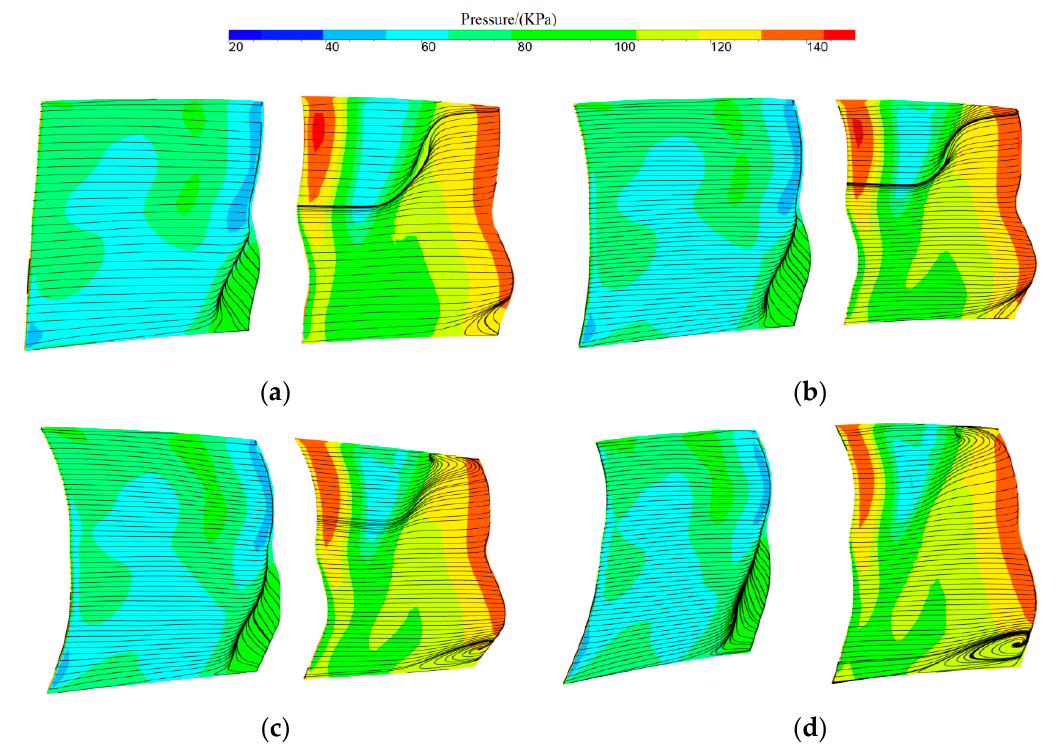
Figure 11. Comparison of static pressure and limit flow line diagram on suction s of NB10, NB20, and NB30. ( a ) ORG. ( b ) NB10. ( c ) NB20. ( d ) NB30.